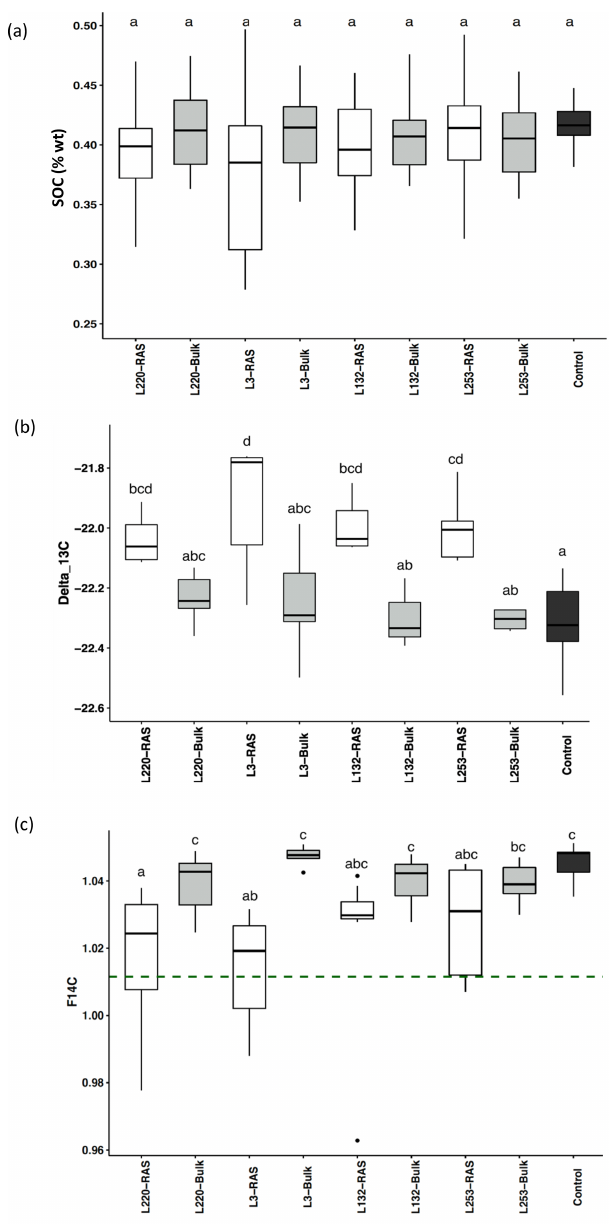
Figure 1. (a) Soil organic carbon (SOC) content of the RAS (root- adhering soil), bulk soil and unplanted control soil. (b) δ 13 C‰ in the RAS, bulk soil and unplanted control soil. (c) F 14 C in the RAS, bulk soil and unplanted control soil. The dotted line indi- cates the F 14 C value of pearl millet tissue, i.e. the new carbon F 14 C (F 14 C = 1 . 012 ± 0 . 002). Different letters indicate significant differ- ence using a Tukey post hoc test ( p< 0 .